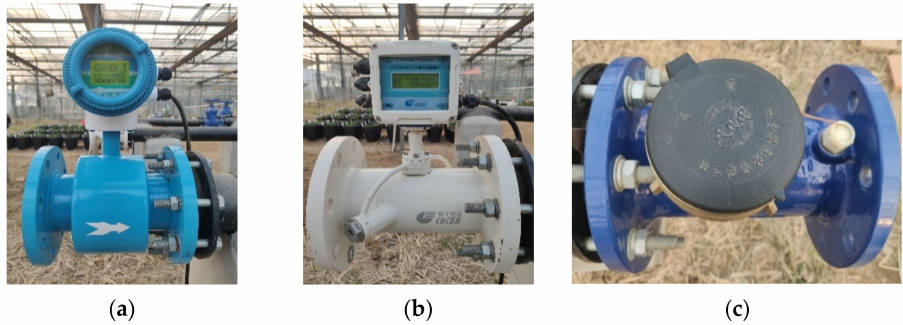
Figure 1. Three pipe metering devices used in this study. ( a ) The electromagnetic flowmeter; ( b ) the ultrasonic flowmeter; ( c ) the water